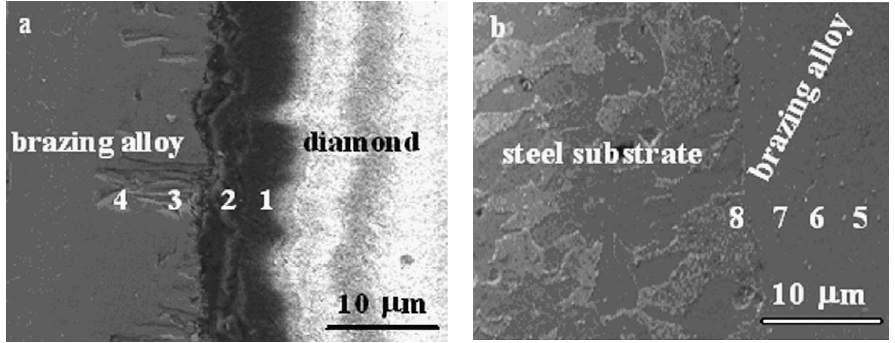
Figure 8. SEM photograph of ( a ) interface between diamond and brazing alloy and ( b ) interface between brazing alloy and steel substrate [21]. Reproduced with permission from Journal of Alloys and Compounds, Elsevier, 2009. Table 1. Chemical compositions (%) by EDX from different locations in Figure 7a. Points